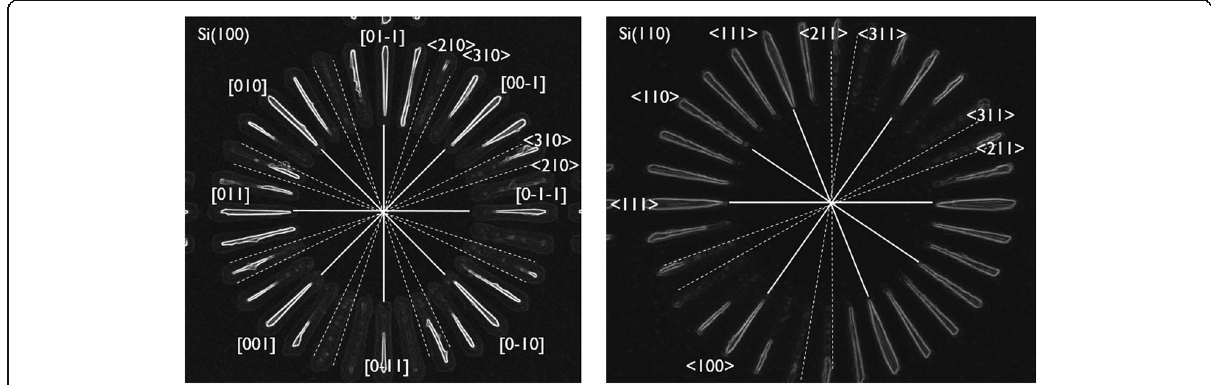
Fig. 5 TD SEM image of a Si(100) (left) and a Si(110) wagon-wheel (right) etched in low-concentration NH4OH (0.4 wt.%) at RT. Specific crystallographic directions are represented by [ ], a family of equivalent directions by < >. The main crystallographic directions (or equivalent planes) are represented by solid lines, the higher index planes by dashed